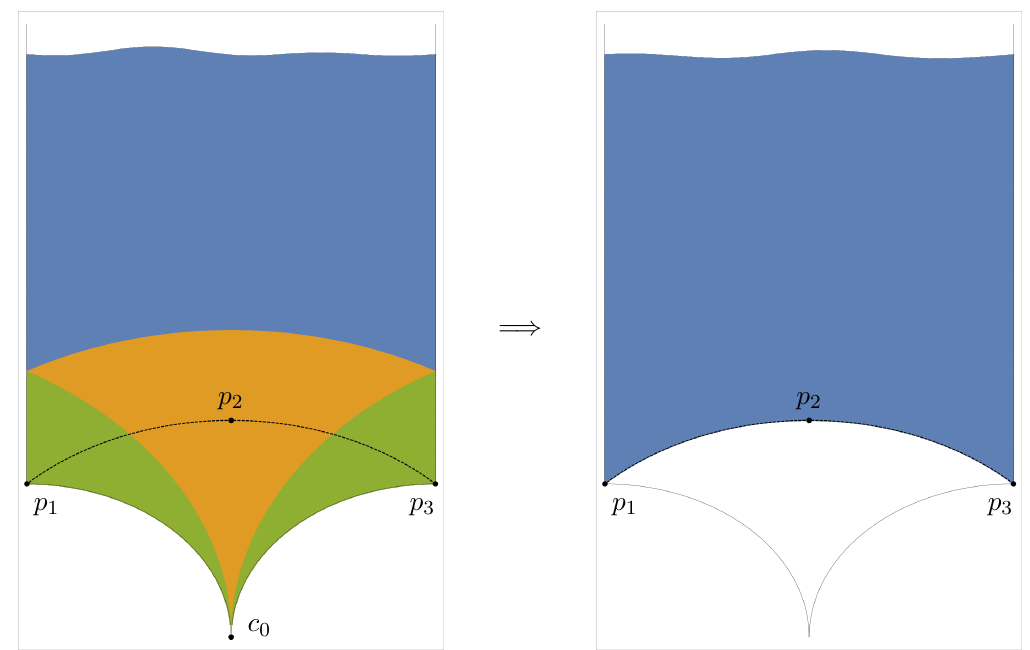
Figure 5 . Left: a fundamental domain X 0 (2) for Γ 0 (2) that is symmetric under the Fricke involu- tion F . Right: a fundamental domain for Γ 2 √ the following: p = e iπ/ 4 / 2 is an orbifold point of order 4 and p 3 point of F and c = 0 is the second cusp of X 2 0